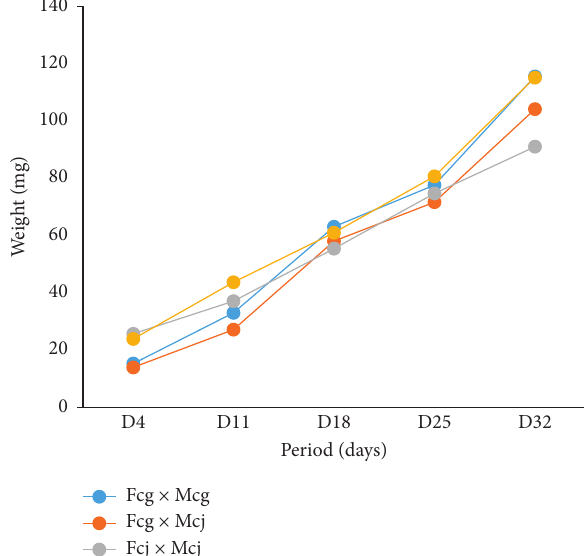
Figure 7: Evolution of the mean weight of larvae according to the genetic type of vitelline resorption (D0) up to 32 days of age (D32) in the reciprocal hybridizations of Clarias gariepinus × Clarias jaensis in controlled conditions. The female was named